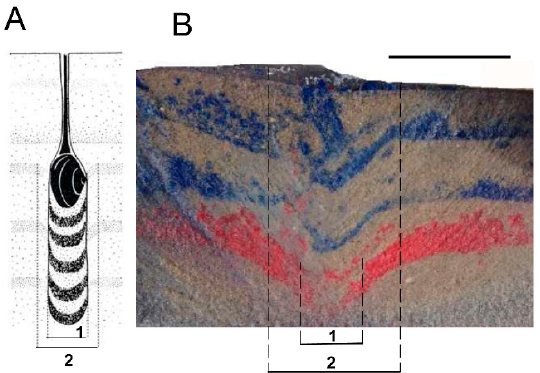
Figure 15. Structure of bivalve escape burrows. ( A ) Structure of a typical escape burrow made by a marine venerid bivalve as interpreted by Reineck [34]. 1—digging core; 2—digging aureole; ( B ) Cross-section of typical escape burrow made by Elliptio complanata inside a PVC pipe originally filled with layers of anastrophically deposited colored sand. 1—digging core; 2—digging aureole. Scale bar in ( B ) equals 5